Question: What does this figure show? Answer in one sentence.
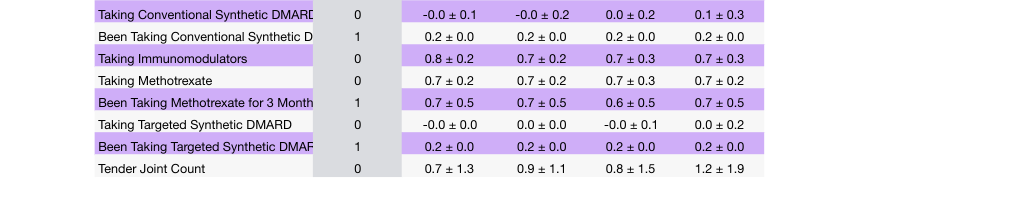
Answer: An example twin record for a single RA patient is shown, which reports the mean and standard deviation of the twins for that patient. A sample of static baseline information is given at the top of the record. A sample of longitudinal outcomes predicted by the model are supplied as rows, with columns indicating the time in months since baseline visit.